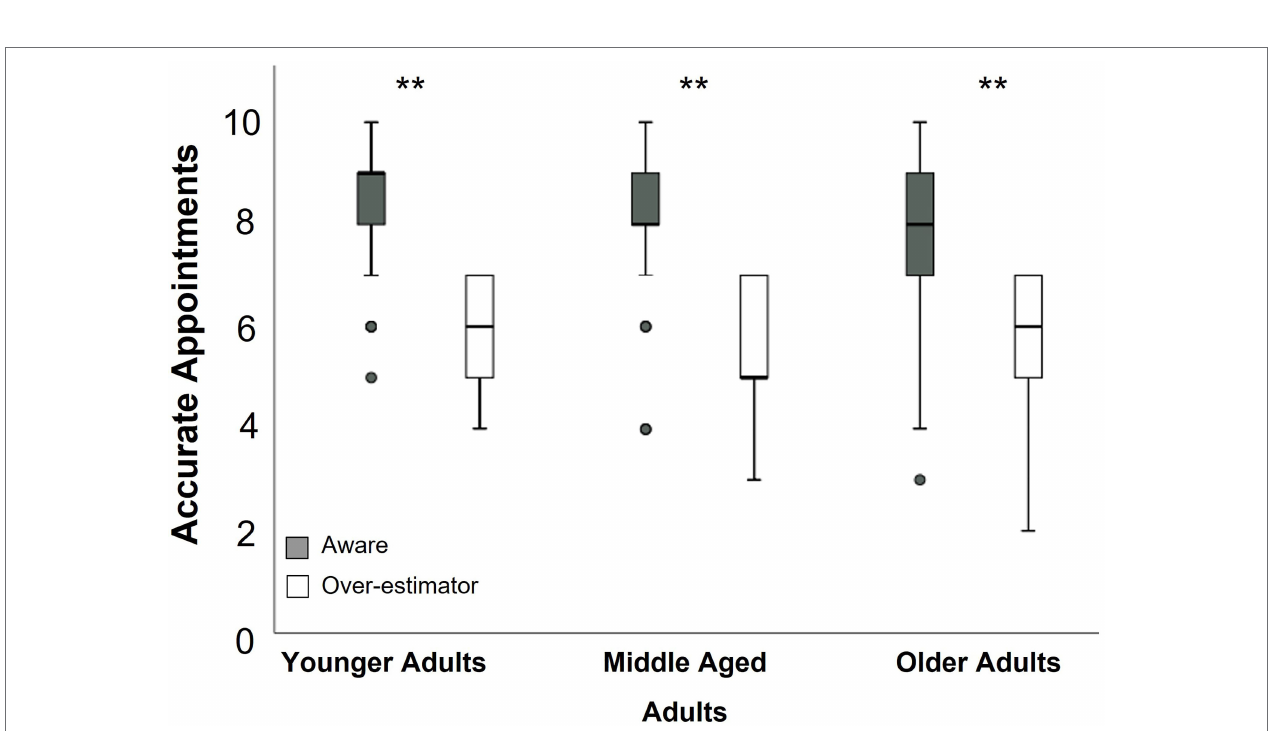
FIGURE 3 | Accuracy of over-estimators compared to aware participants across the adult lifespan. ** p <